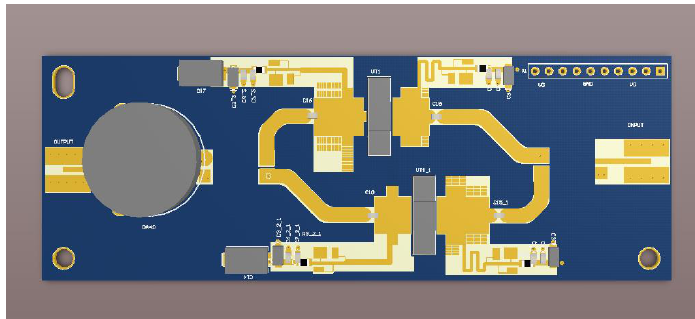
Fig. 8. Topology of the developed push-pull power amplifier on a printed circuit board.